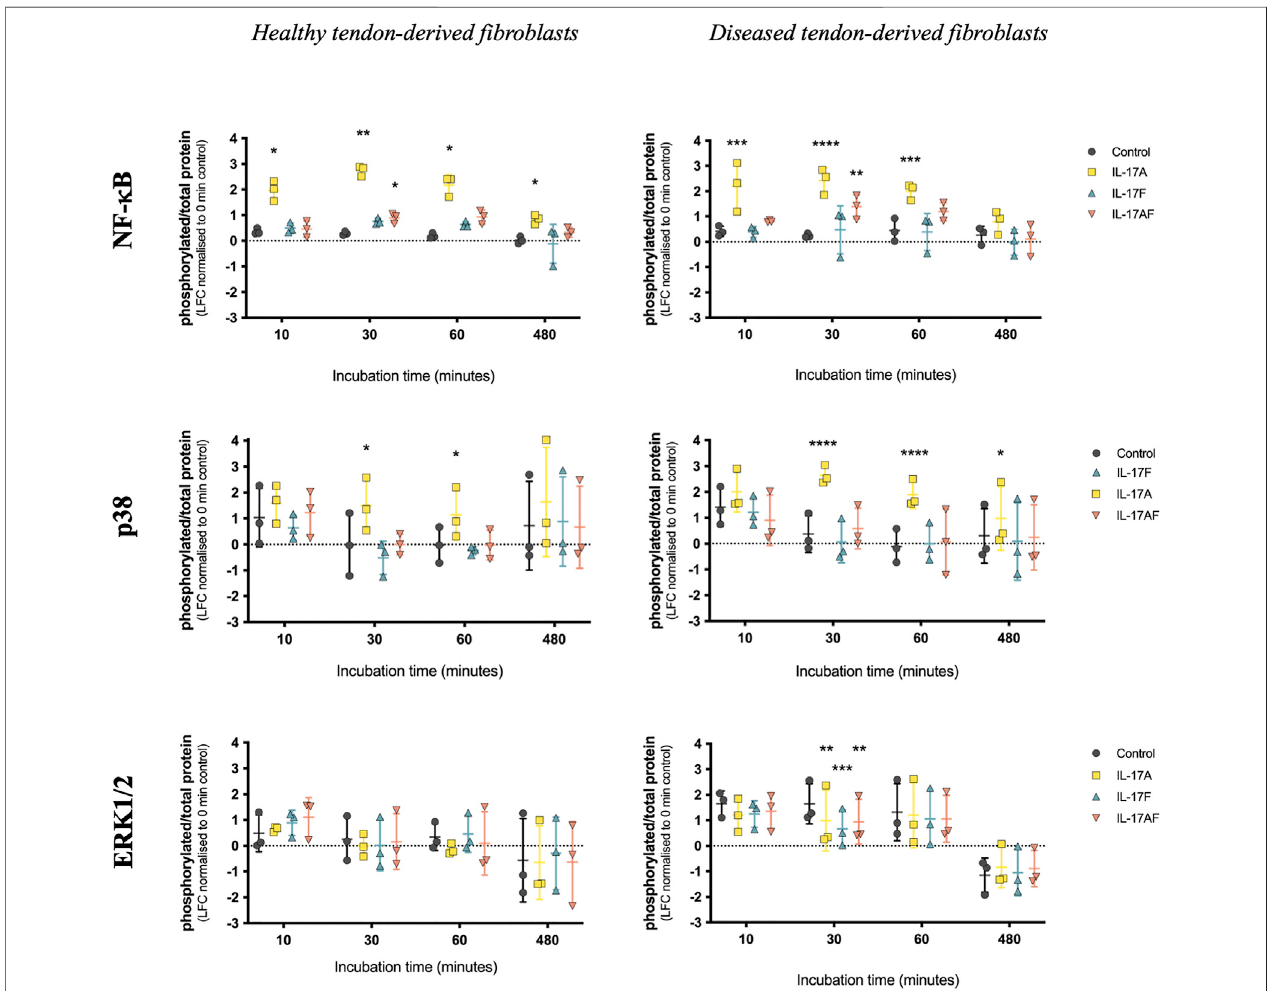
FIGURE 4 | Activation of p65 NF- κ B, p38, and ERK1/2, after stimulation with 10 ng/ml IL-17A, IL-17F, or IL-17AF in tendon fi broblasts derived from healthy hamstringorsupraspinatustendonswithlargeormassivetears.Phosphorylatedproteinovertotalproteinratioscomparedtobaselinecontrol(0 min).Two-wayANOVA with Dunnett ’ s multiple comparison ’ s test. Mean ± SD. N (cid:1) 3. * (cid:1) p < 0.05, ** (cid:1) p < 0.01, *** (cid:1) p < 0.001, **** (cid:1) p <